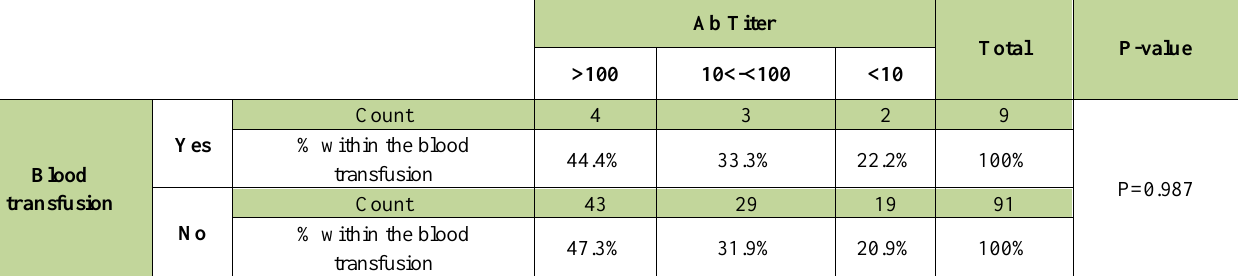
Table 13. Analysis of the relationship between the anti-hepatitis B titration in subjects with complete blood